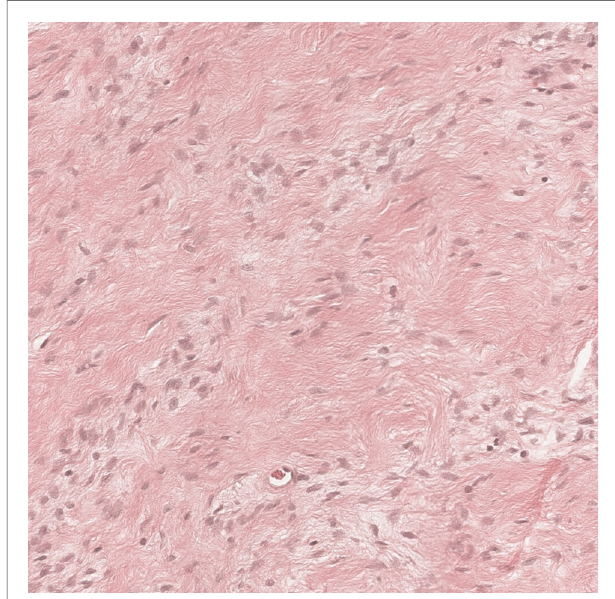
FIGURE 3 | Photomicrograph of pancreatic neuro fi broma. Collagen fi bers contain a large number of spindle cells (H&E stain, ×100).